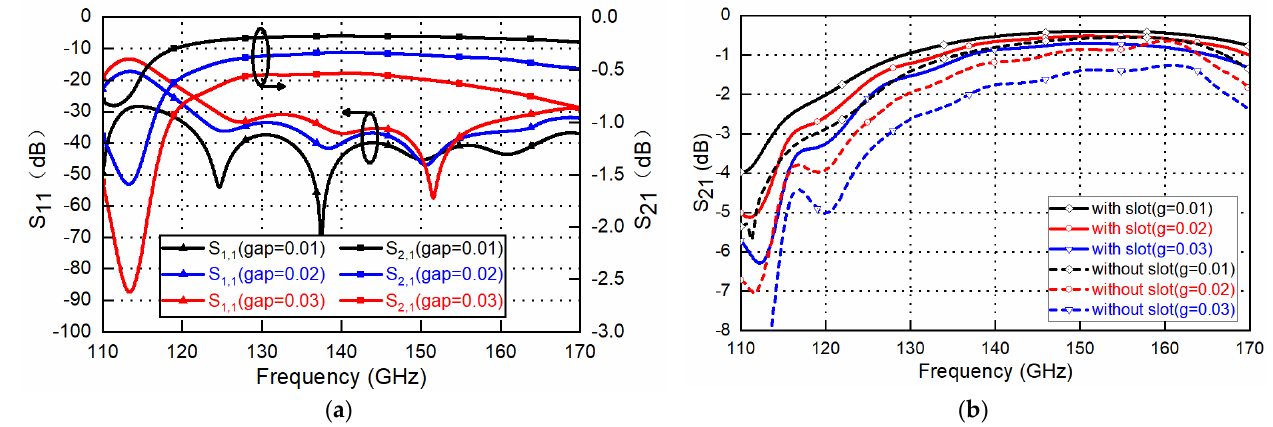
Figure 5. Simulated frequency response of the designed D-band GWG line ( a ) and with and without rectangular slots along the groove channel ( b ).